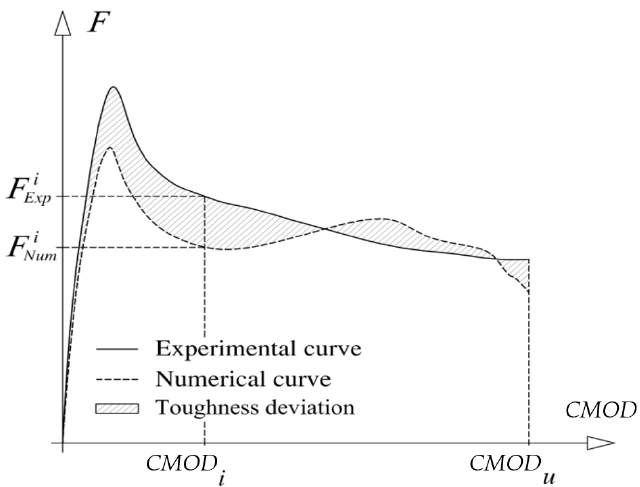
Figure 13. Schematic representation of the force–crack mouth opening displacement ( F − CMOD ) registered experimentally and obtained numerically by the inverse analysis. The obtained parameters defining the - relationship, and the equivalent fitting f is the tensile strength, are, error, e , are indicated in Table 8, where and ct 1 2 respectively, the stress at the first and second post-peak point of the crack opening, 1 and , and is the ultimate post-peak point of the crack opening. The graphical rep- 2 u resentation of these - laws is presented in Figure 14. For the same crack width level, no significant differences in the parameters were observed (Figure 14). Table 8. Parameters of the σ − ω relationship obtained by inverse analysis of the 3PNBBT. Concrete